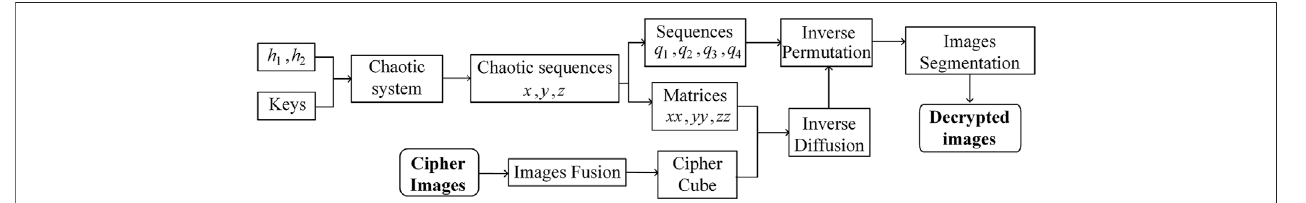
FIGURE 3 | Decryption fl owchart.